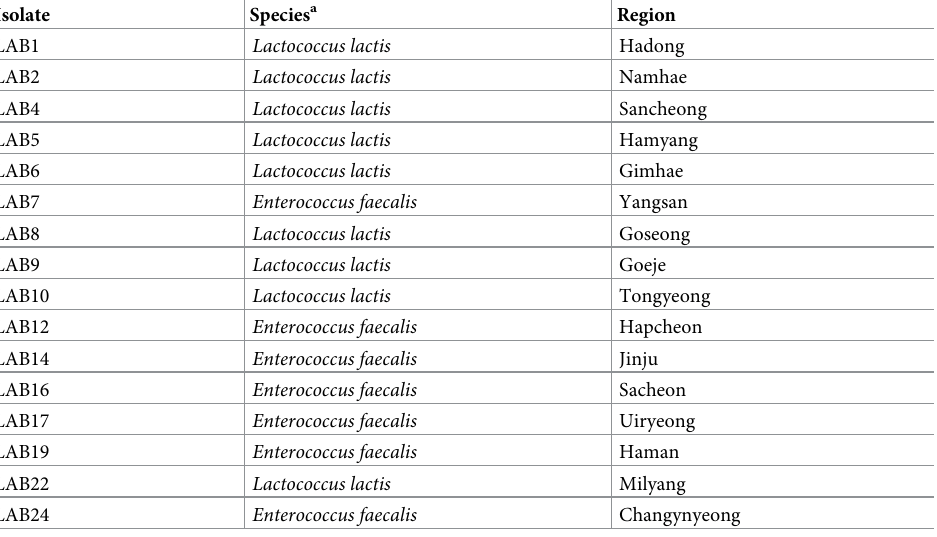
Table 1. LAB isolates obtained from the guts of bean bug adults collected from soybean fields during 2021–2022 in a natural infection rate survey.